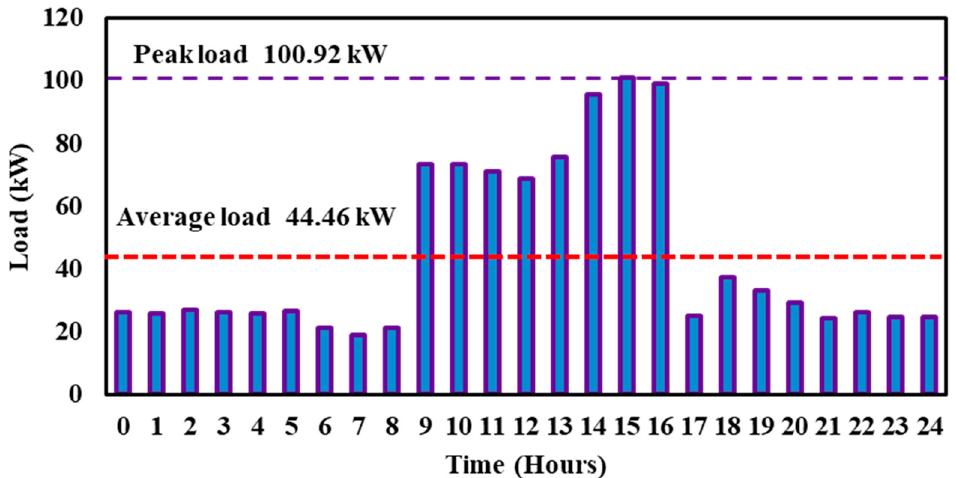
Figure 2. Average daily load profile of the case study area.